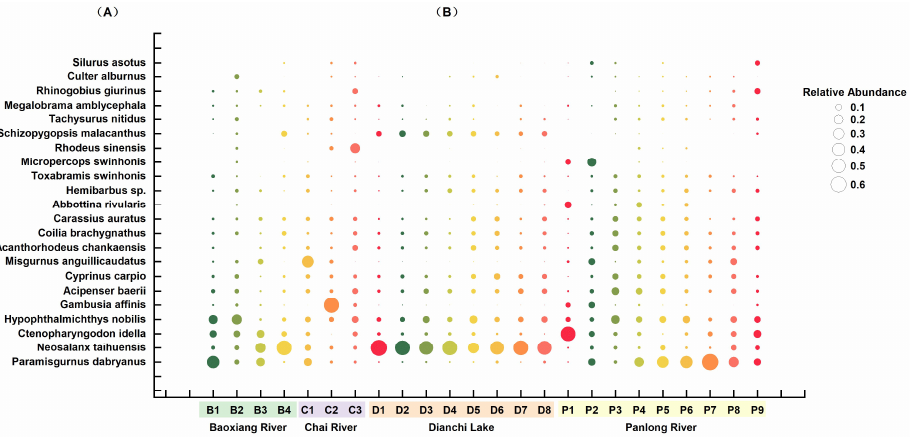
Figure 3. Community composition and relative abundance distribution of fish species (top 22) were revealed by eDNA metabarcoding at each sampling site. ( A ) Top 22 fish species in order of abundance. ( B ) Relative abundance distribution of each species at the sampling sites.